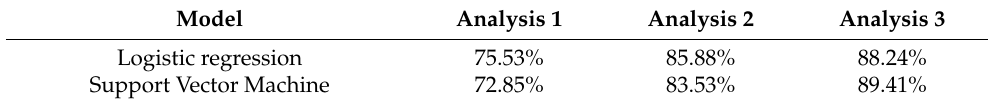
Table 4. Logistic regression and support vector machine global accuracy scores for the three analyses.